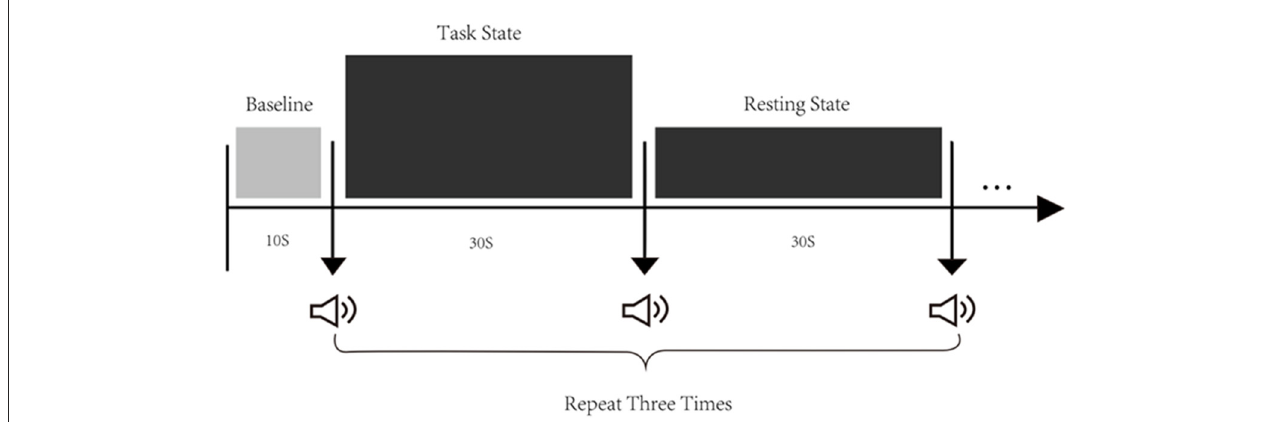
FIGURE2 Experimental procedure. There are three states of fNIRS testing, namely, the baseline, the task state (TS), and the resting state (RS). The first 10s before the test were taken as the baseline. Then, start three tests, each including a 30-s task and a 30-s resting.